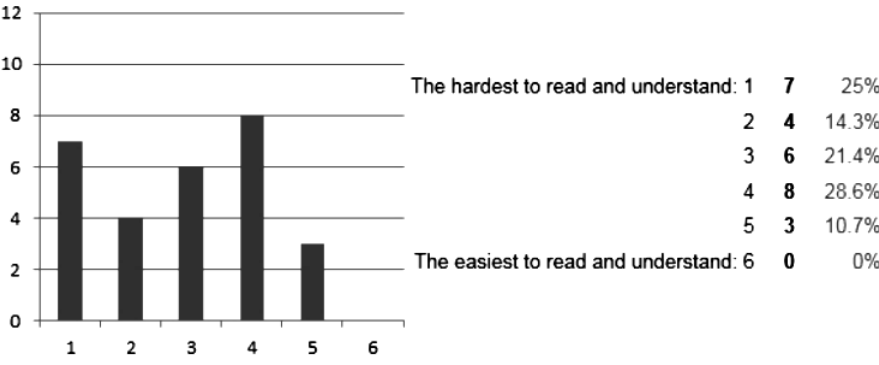
Figure 6. Distribution of marks – App Inventor-like